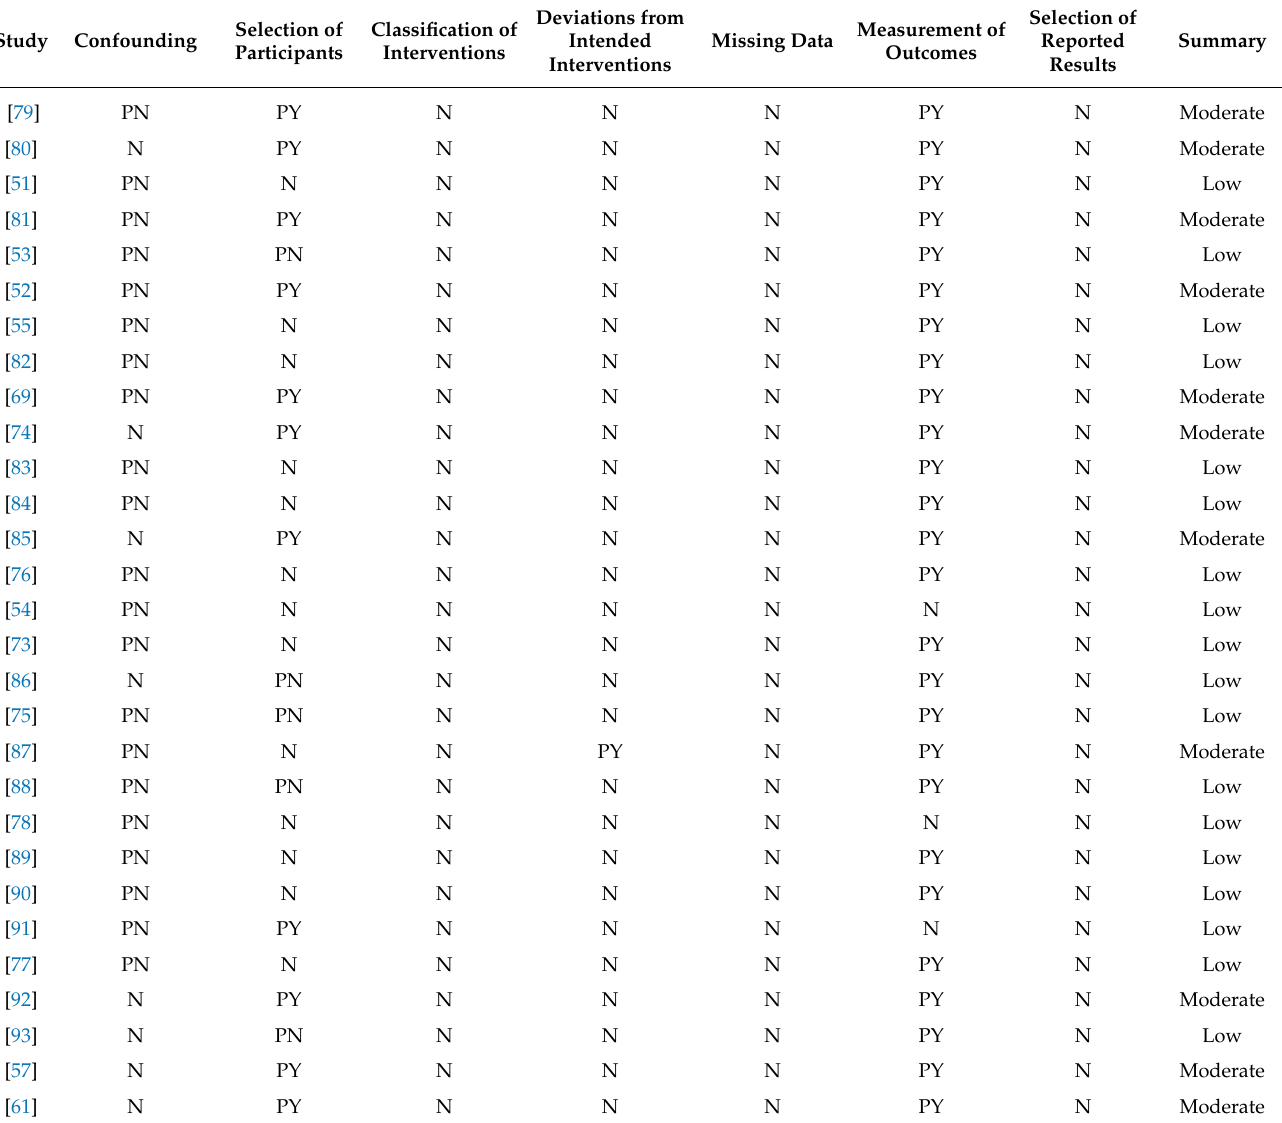
Table A1. Risk of bias